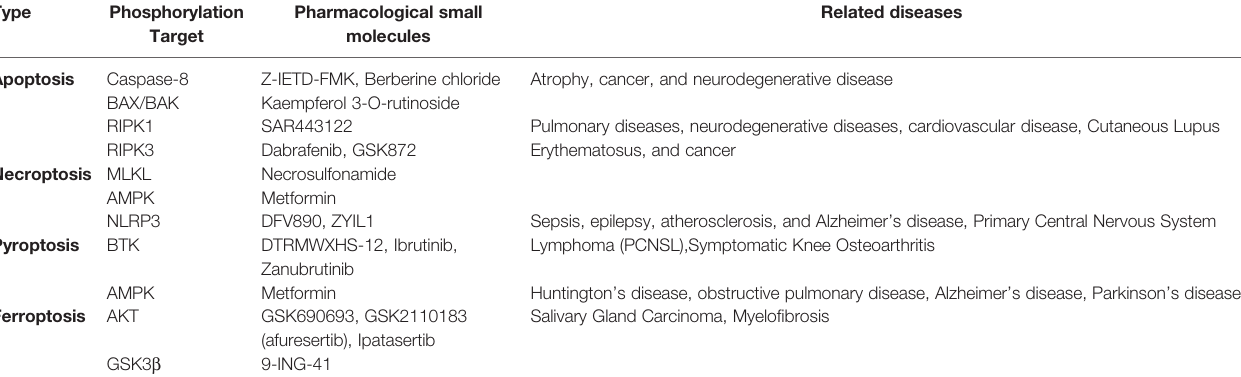
TABLE 2 | Clinical Trials Targeting cell death -Related Kinases or